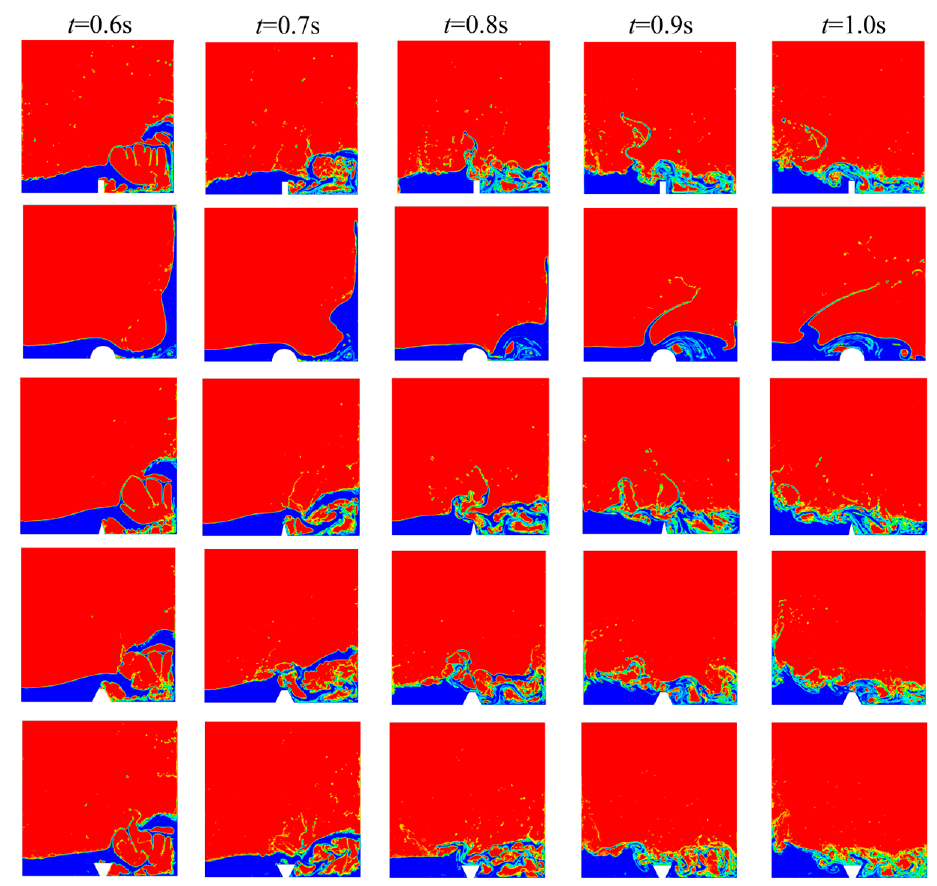
Figure 7. The free surface flow field of obstacles of different shapes at 0.6–1.0 s. Between t = 0.6–1.0 s, the dam break water flow of barriers of various forms on the right side of the container becomes chaotic and disorganized. The backwater body repeatedly crosses impediment and collides with right wall of the container, splashing forth several water droplets. After being slapped on the top plane of the obstacle, the water body that falls from the right wall and flows to the obstruction will roll and flow back to the left wall. The force-bearing area of a triangle obstruction is a cusp, which theoretically has the minimum interaction force with the water flow. The rectangle and trapezoid have the same top area; hence, their free surface flow changes are identical. The inverted trapezoid has the maximum force-bearing surface and the lowest water body rise. The arc-shaped design of semicircular barriers prevents the water from breaking as rapidly as the prior obstacles, and most of water flows over slightly because of the obstacle. Figures 8 and 9 show the time between the initial return to the left wall and the second arrival on the right wall owing to downstream obstructions. Compared to when there